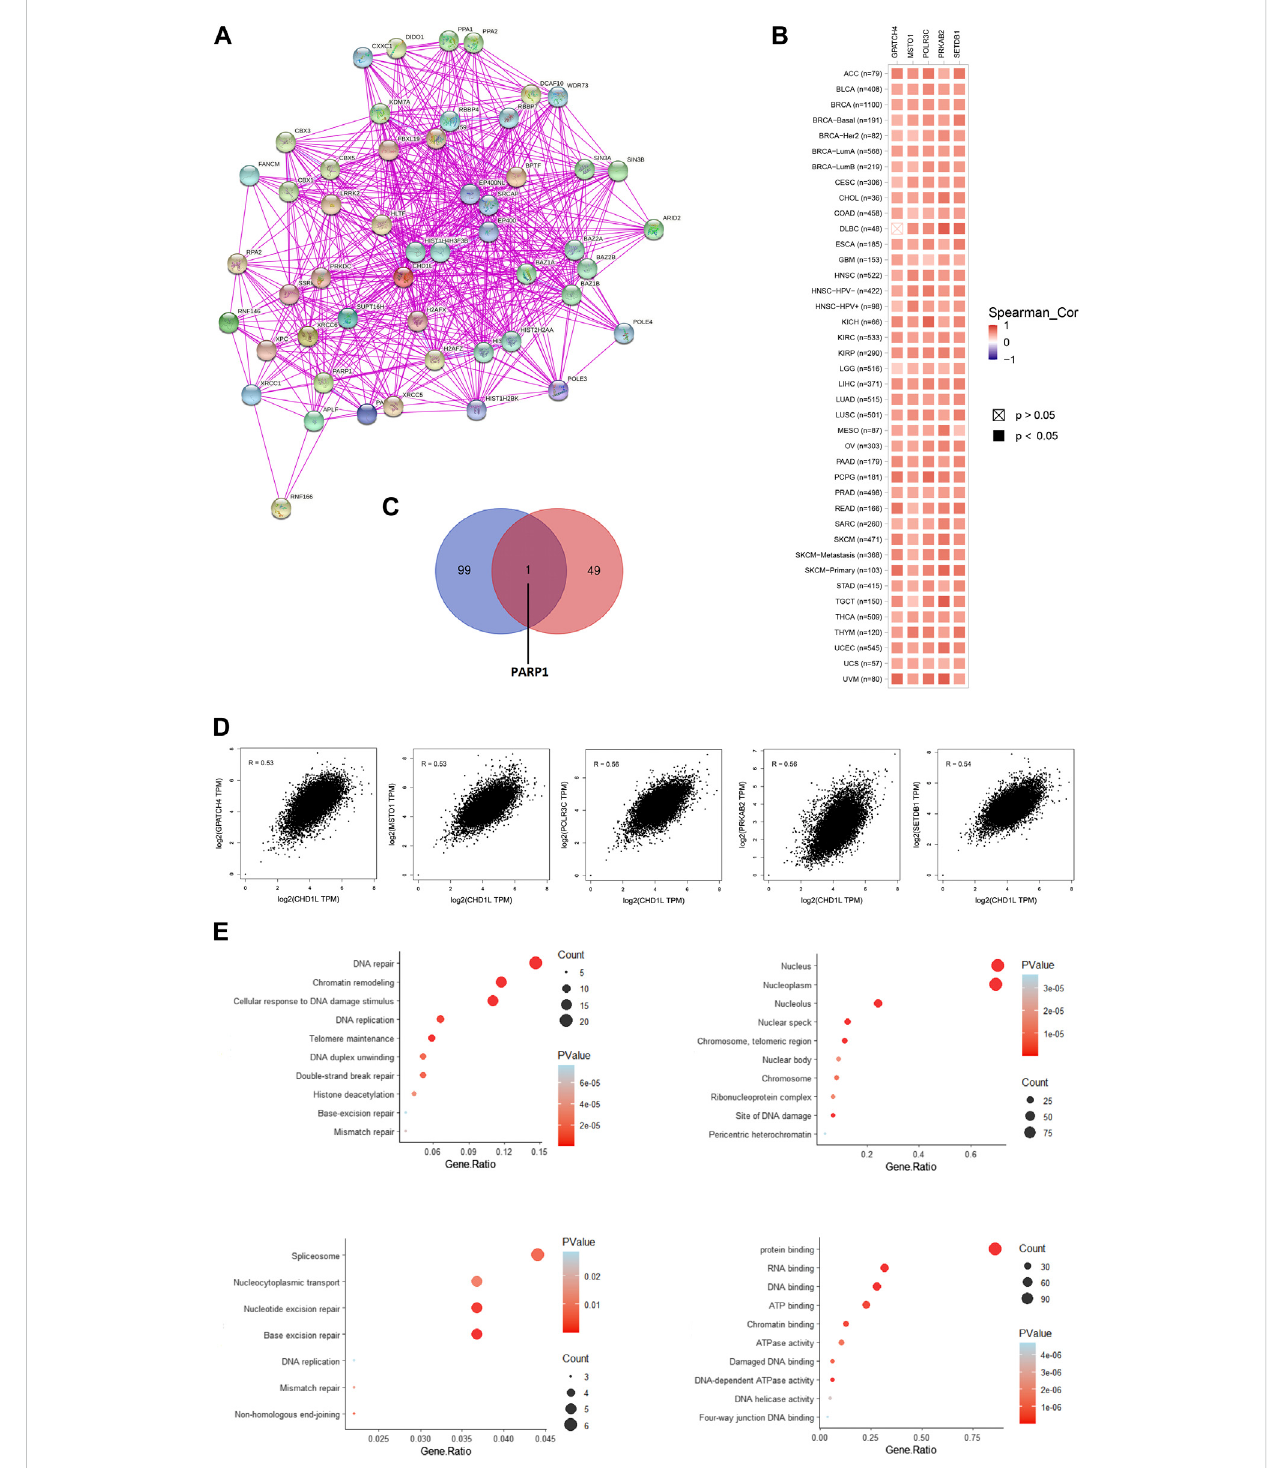
FIGURE 9 CHD1L-protein network interactions. (A) A map of the top 50 CHD1L interacting proteins as determined by the STRING database. (B) Heatmap for top fi ve CHD1L-correlated proteins in the tumor tissue. (C) Venn diagram showing the intersection between CHD1L interacting and correlating proteins. (D) Expression correlation between CHD1L and genes (GPATCH4, MSTO1, POLR3C, PRKAB2, and SETDB1) as determined by GEPIA2. (E) KEGG/GO enrichment analysis based on CHD1L-binding and interacted genes.(a),